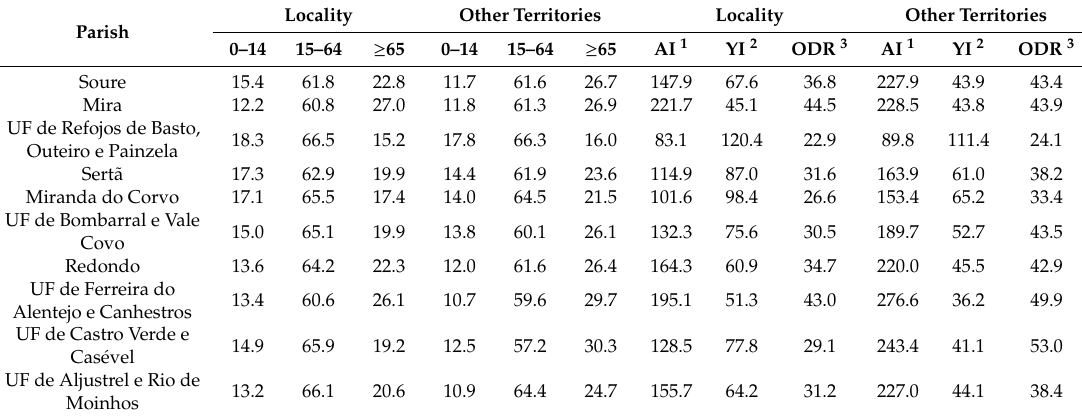
Table 7. Age groups (%) and demographic indices in localities with the municipal headquarters, and other territories belonging to APU (TIPAU) and Code 3 (DEGURBA)